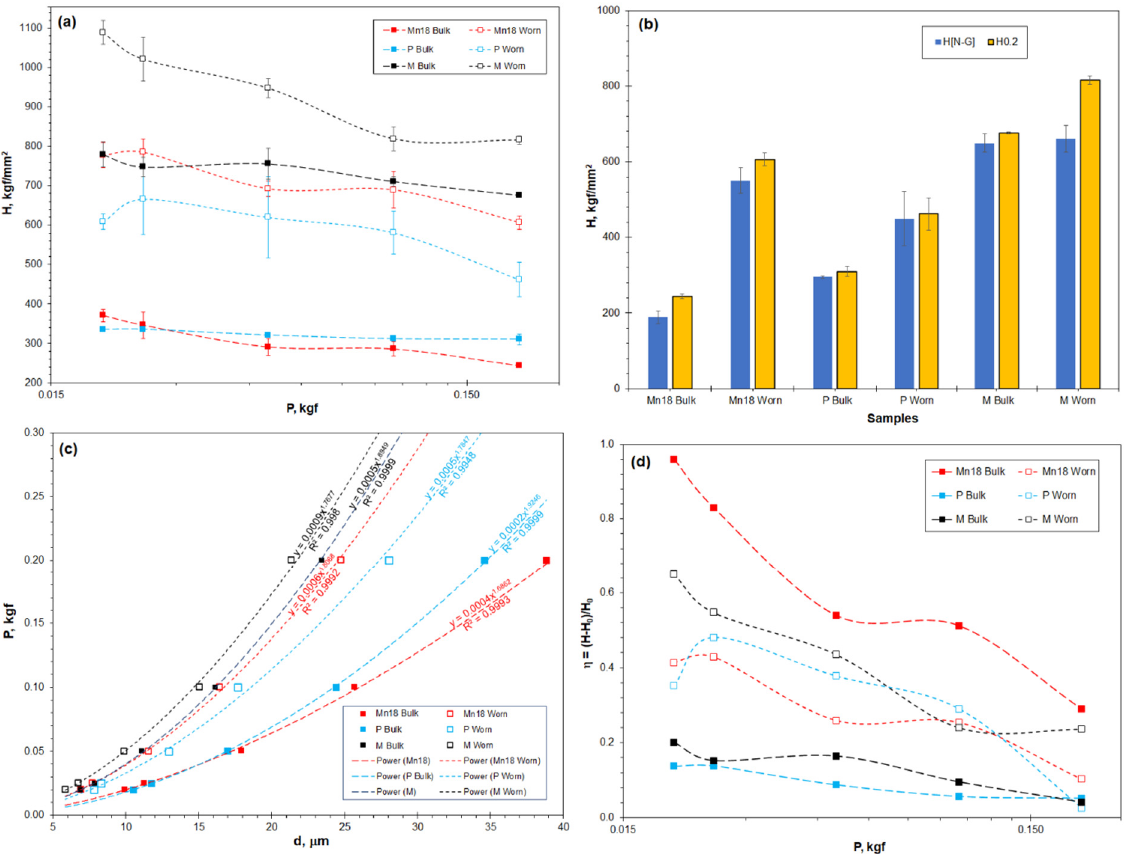
Figure 10. The hardness and ISE properties of the three different microstructure steels and their worn surfaces: ( a ) the measured microhardness plotted versus indentation load; ( b ) the real hardness ( H N-G determined from the Nix-Gao model) as compared to the microhardness at the indentation load 0.2 kgf ( H 0.2 ); ( c ) Meyer’s power profiles; and ( d ) the ISE significance coefficient η .